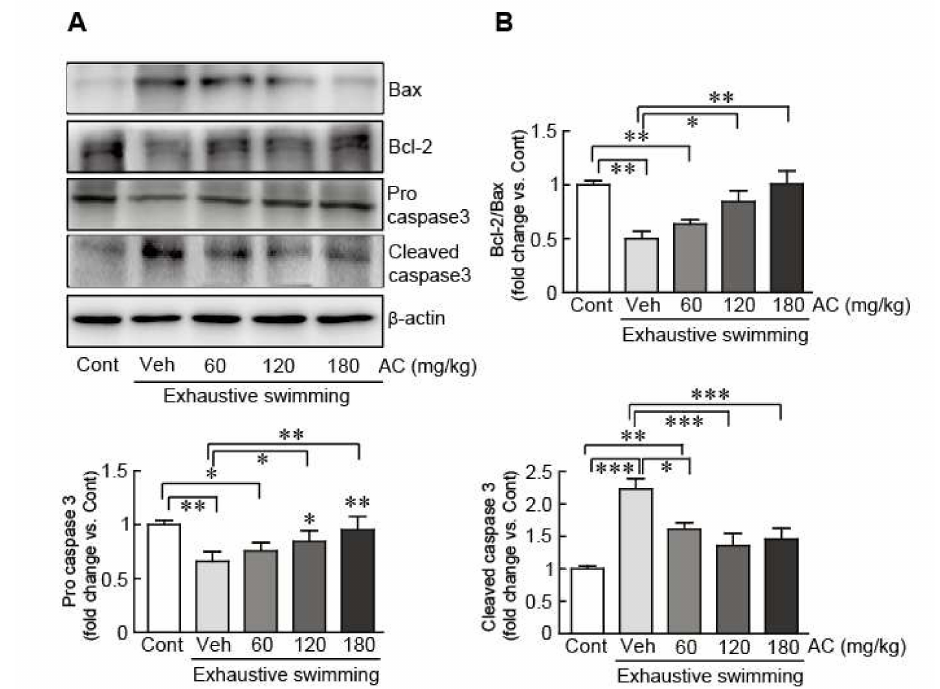
Figure 6. AC extract suppressed exhaustive swimming-induced apoptosis in gastrocnemius muscle. ( A ) Western blot analysis of Bax, Bcl-2, pro-, and cleaved caspase 3 protein expression levels in rats after AC pre-treatment for 3 weeks. ( B ) The protein expression levels were quantified by scanning densitometry. β -actin was used as the loading control. Western blot analysis was performed in triplicate with three independent samples. Data are mean ± standard error of mean (SEM). Significance was measured using one-way analysis of variance (ANOVA) followed by Bonferroni’s post hoc test. * p < 0.05 and ** p < 0.01, and *** p < 0.001. Cont, control; Veh, vehicle-treated; 60, 120, and 180 AC, 60, 120, 180 mg / kg AC extract-treated groups, respectively. AC, Aralia continentalis kitagawa